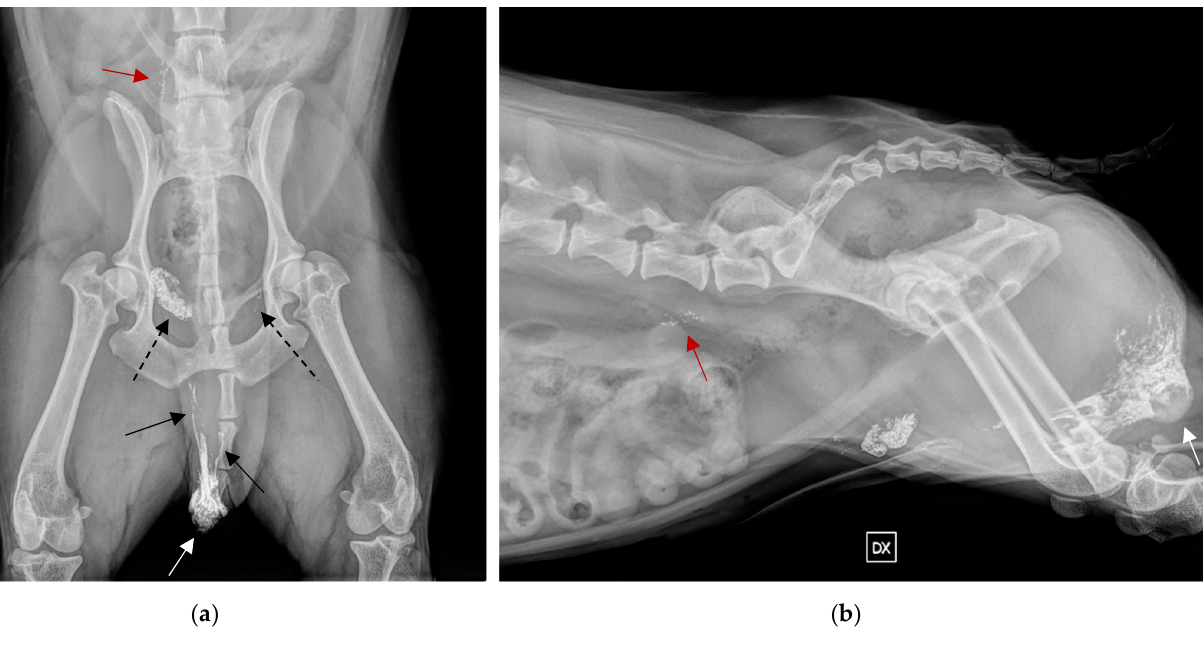
Figure 3. Radiographic indirect lymphangiography 24 h post Lipiodol in two orthogonal views of a MCT in the scrotum with three SLNs: ( a ) VD view of the pelvic region. The Lipiodol was injected at the periphery of the tumour in the scrotum. Lymphatic vessels are visible on both views extending cranially (black arrows), inguinal lymph nodes are highlighted by the (black dashed arrow ); ( b ) fight lateral view of the pelvic region. The right medial iliac SLN can be assessed ventrally to L6, pointed by the black arrow, and to the right of L6 in the VD highlighted by the red arrow. The location of the primary MCT in both VD and right lateral is highlighted by the white arrow .